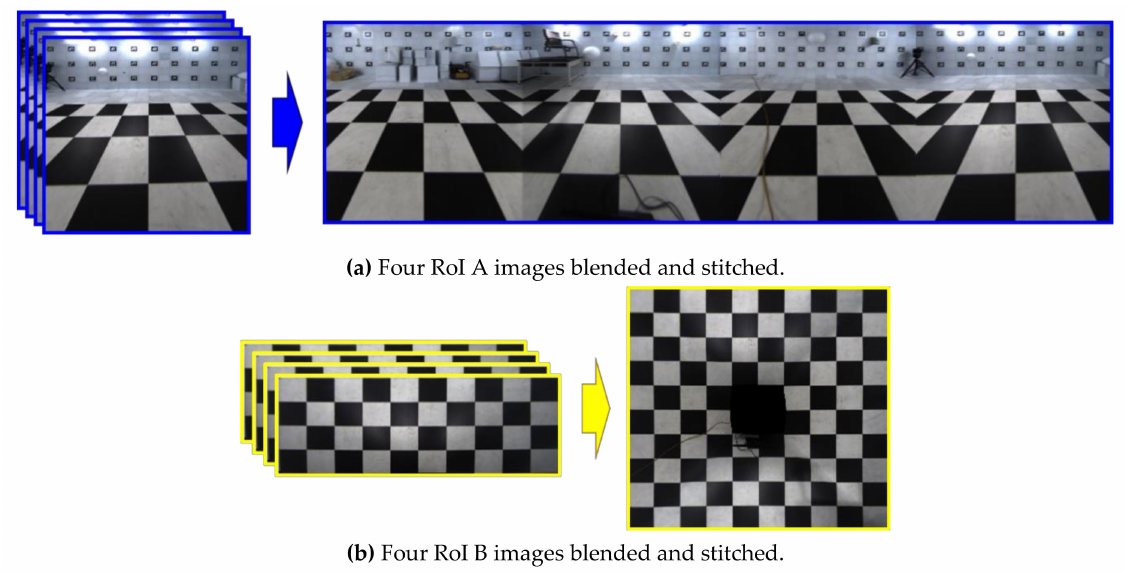
Figure 7. Blended and stitched RoI A and B images using the four images in Figure